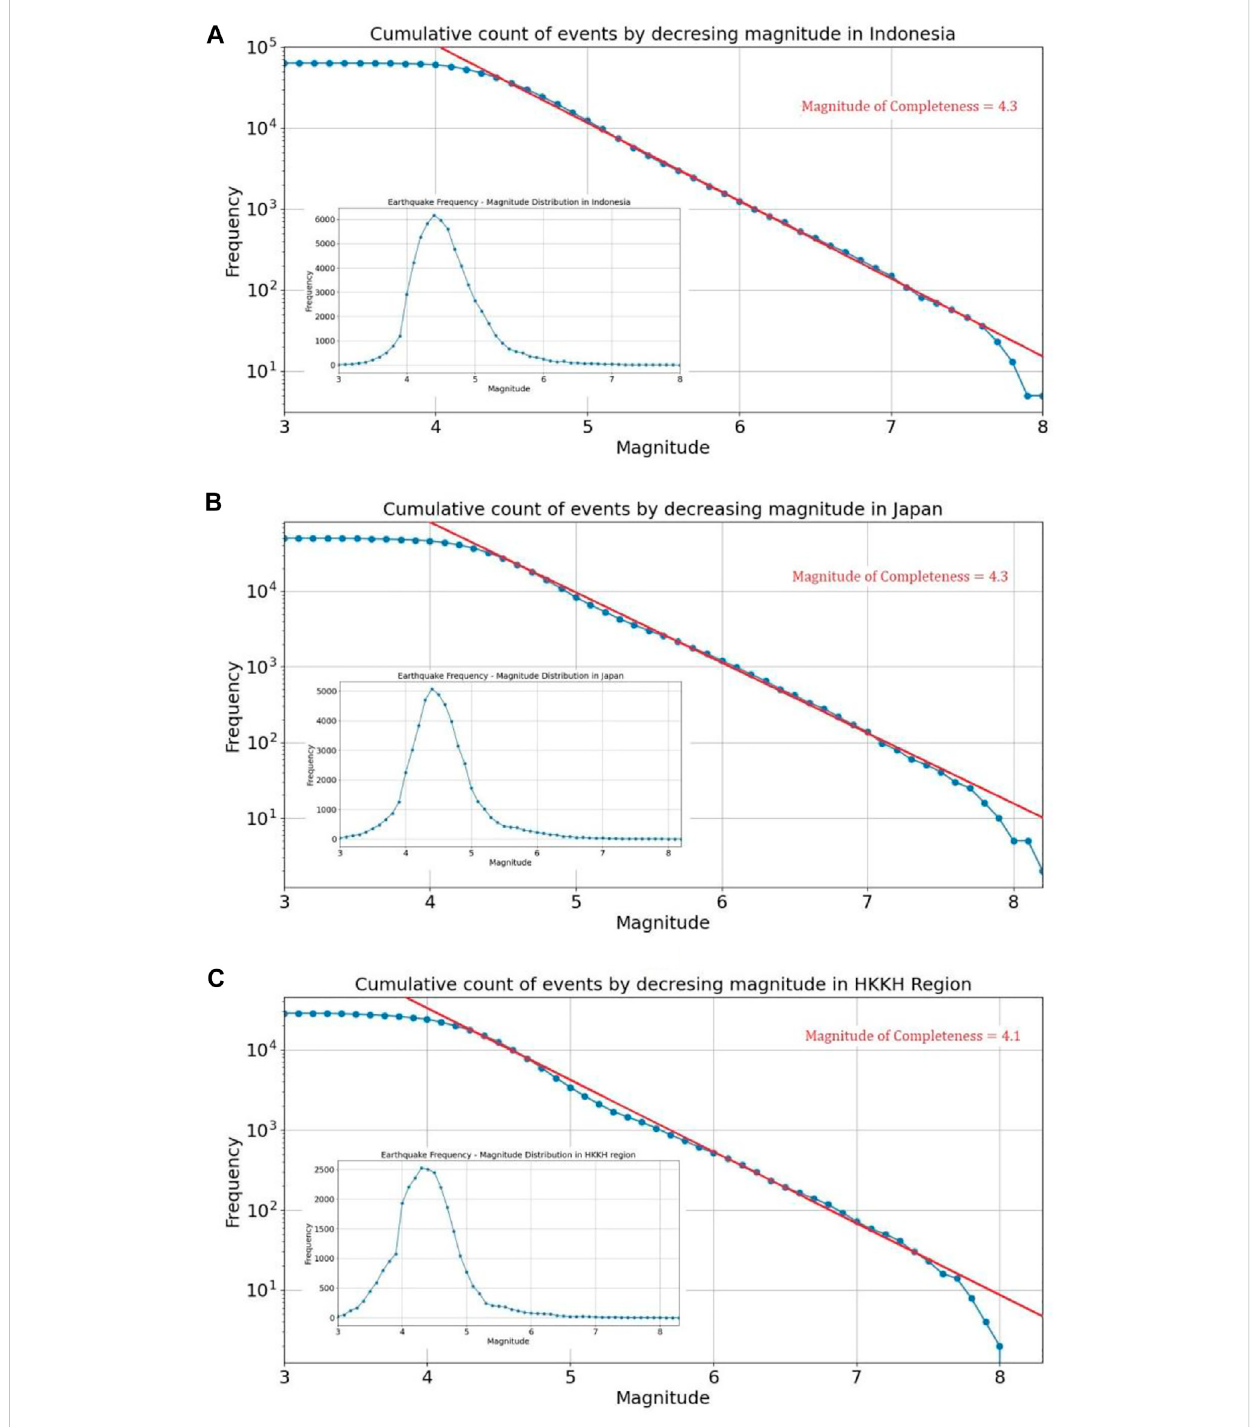
comparable tendencies. Evidence was presented by Swindles et al. (2017) that glacial extent, driven by climate, impacted the frequency of seismic events and volcanic activity in Iceland throughout millennia.